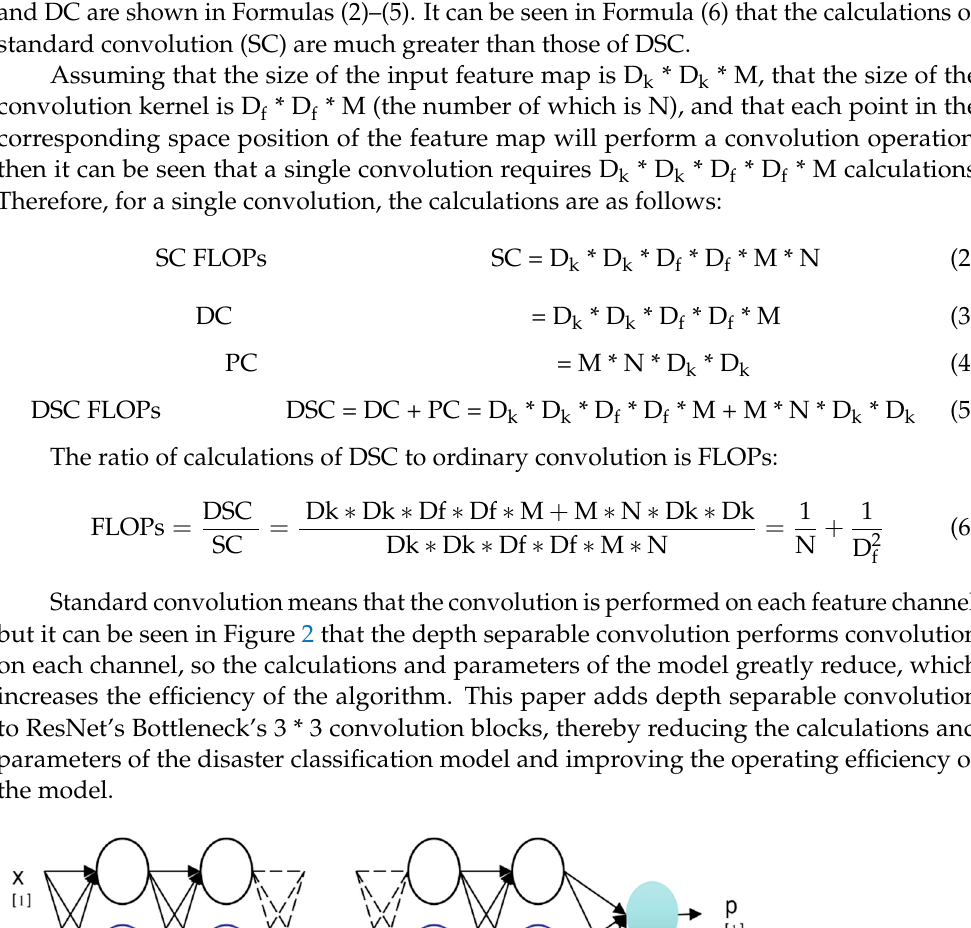
Figure 3. DSC operation diagram.